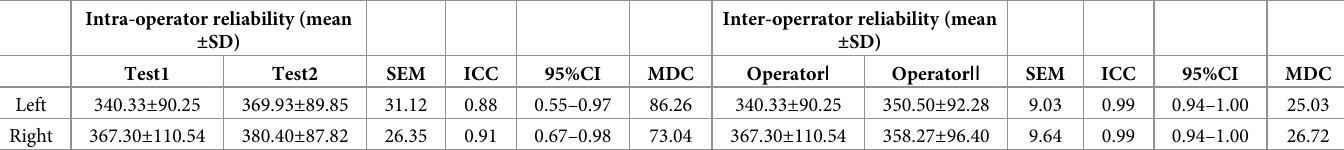
SD, standard deviation; SEM, standard error mean; ICC, intraclass correlation coefficient; MDC, minimum detectable change. 95%CI, 95% confidence interval; S, Dynamic